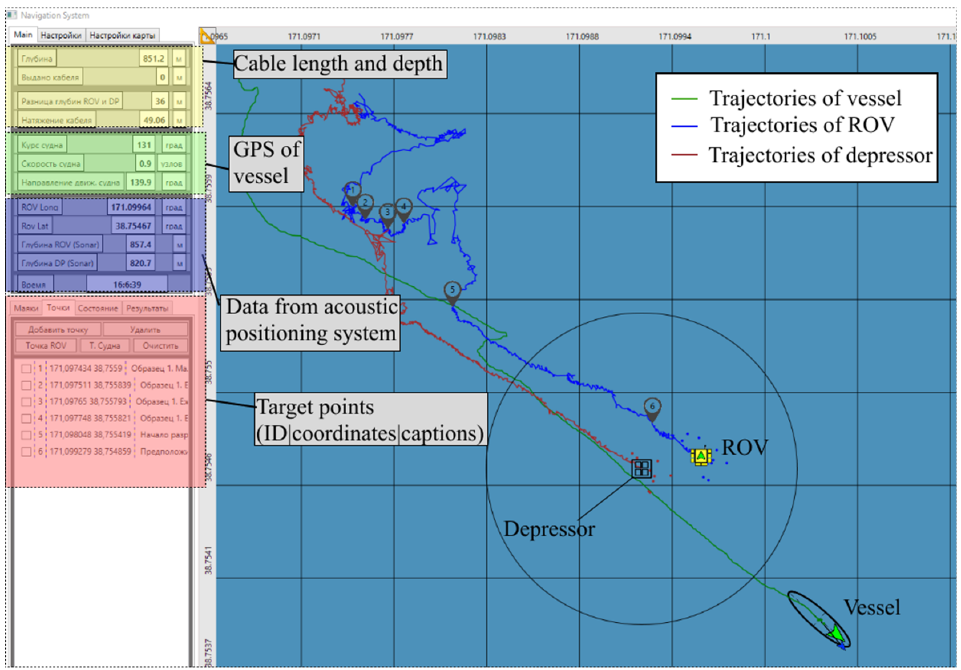
Figure 6. Graphical interface of the smart support system for ROV operators deployed for an underwater operation.